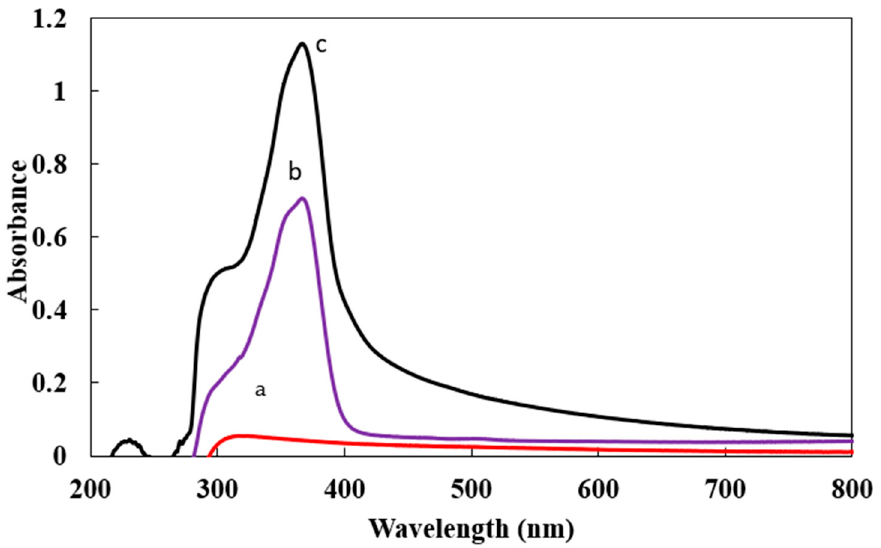
Figure 2. UV visible absorption of (a) Ca-Alg